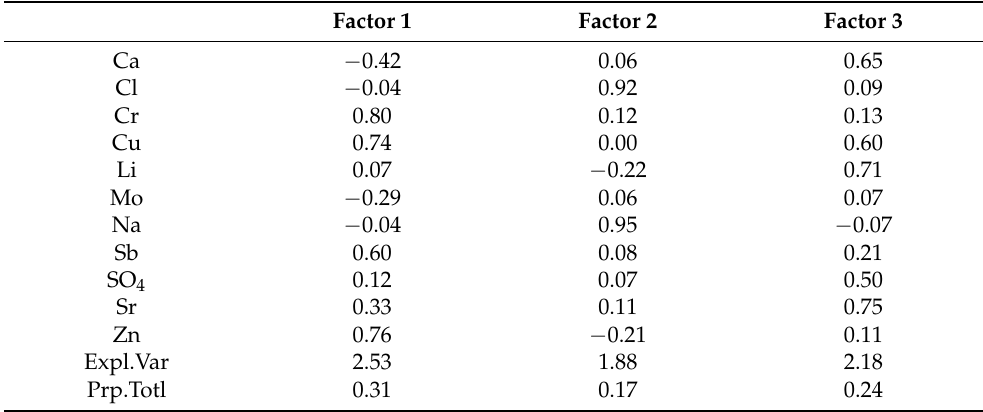
Table 4. Factor loadings (Varimax rotation) for the filter samples of PM 10 and PM 2.5 ( p <